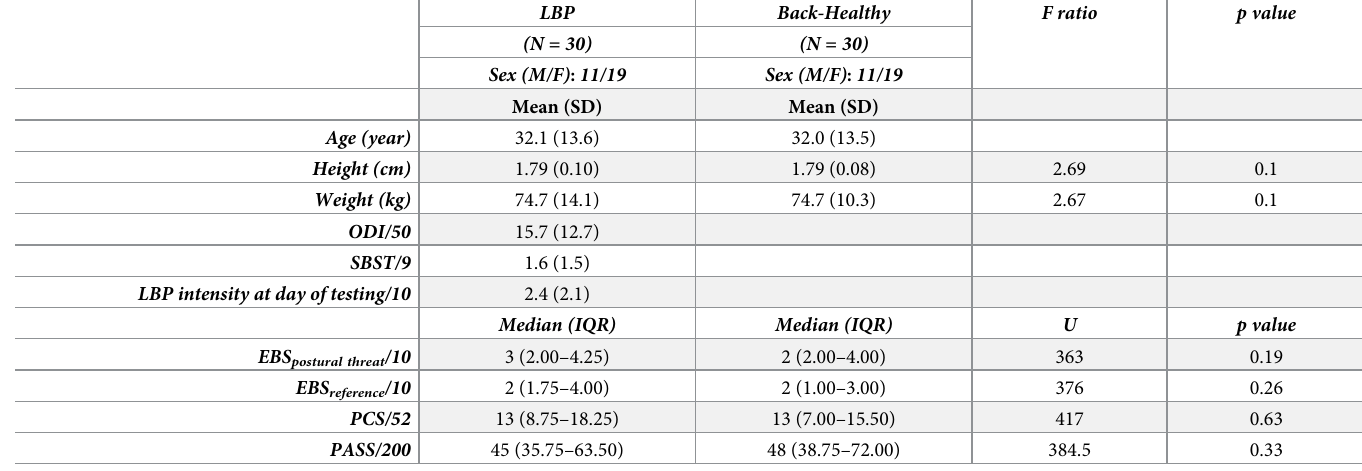
Table 1. Participant characteristics.